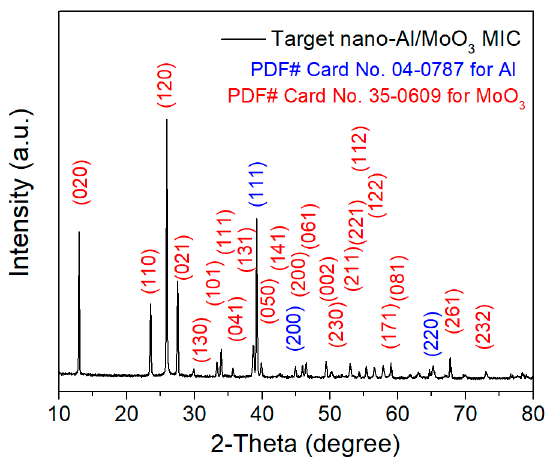
Figure 3. Typical X-ray di ff ractometer (XRD) pattern of the as-obtained nano-Al / MoO 3 MIC.